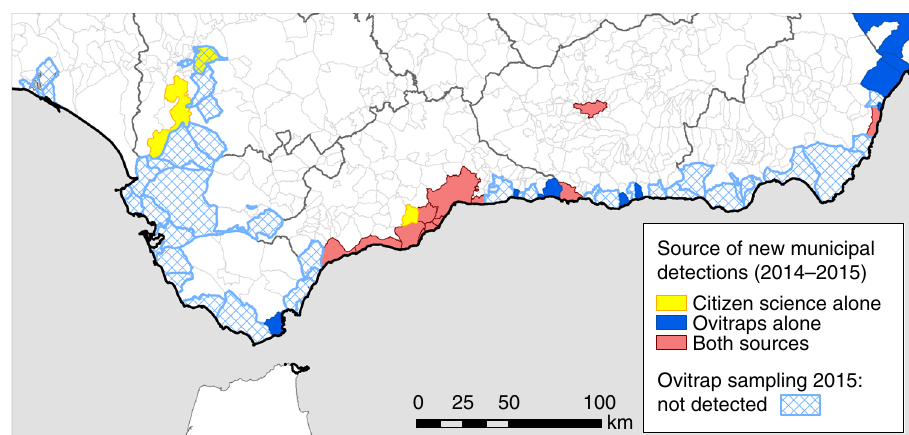
Fig. 2 New detections based on the ovitrap and Mosquito Alert tiger mosquito surveillance performed in the south of Spain in 2014 – 2015 (as in Fig. 1). Municipalities surveilled with ovitraps during 2015 but ending in no-detections are shown in light dashed blue (source data from ref. 18). Note that a lot of sampling effort is unsuccessful (light dashed blue). Successful detections come from ovitraps alone (dark blue), citizen scientists alone (yellow) or both ovitraps and citizen scientists (light red). In 4 out of the 12 red municipalities, ovitrap surveillance was triggered by citizen science alerts through the Mosquito Alert platform but citizen science reports cannot always be con fi rmed in the fi eld (e.g. ovitraps are not always placed in municipalities where citizen science reports suggest presence; even when they are placed in these municipalities low ovitrap or population densities may generate false negatives). Boundary data from Spanish National Geographic Institute 53 . © Instituto Geográ fi co